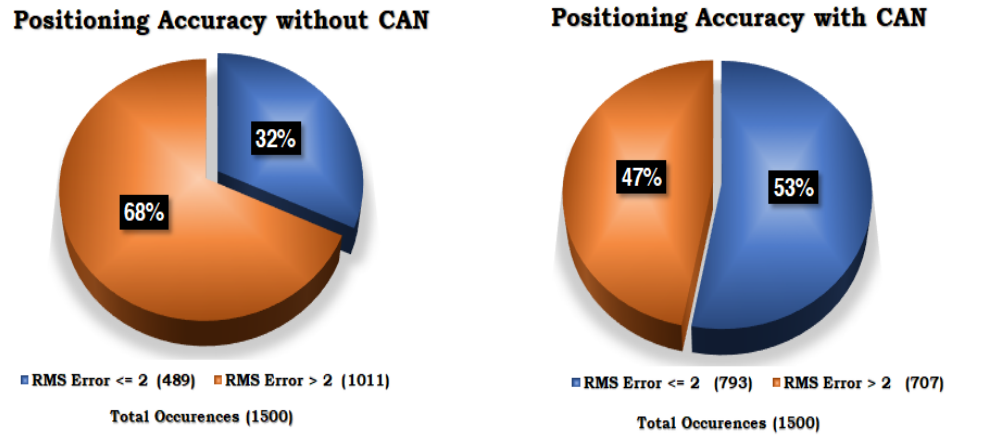
Figure 10. GNSS accuracy achieved in a highly degraded environment (P3) with and without